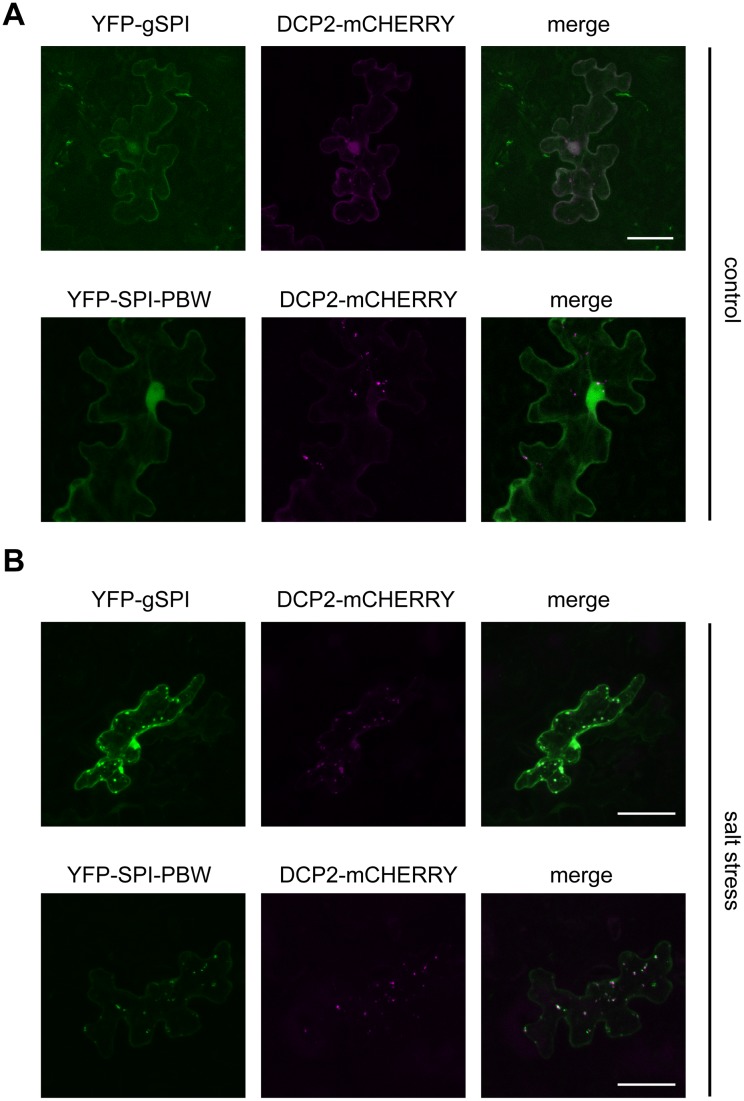
Colocalization studies with YFP-fusions of SPI (column I) and DCP2-mCHERRY-labeled P-bodies (column II) in transiently transfected Arabidopsis leaf epidermis cells.Column III presents the overlay picture between columns I (green) and II (magenta). (A) Under nonstress conditions, YFP-gSPI (upper row) and YFP-SPI-PBW (lower row) are evenly distributed throughout the cytoplasm. (B) YFP-gSPI (upper row) and YFP-SPI-PBW (lower row) accumulate at DCP2-mCHERRY-labeled P-bodies after incubation of transfected leaves on ½Murashige and Skoog (MS) medium supplemented with 140 mM NaCl for 10 h. Scale bar: 25 μm.